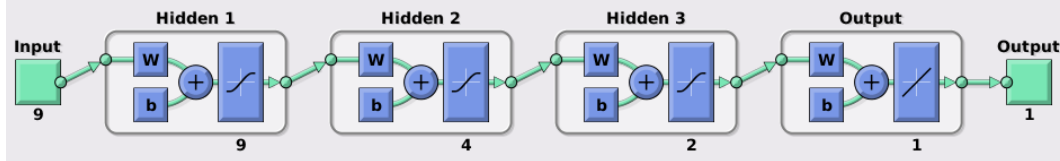
Figure 3. An exemplary structure of the neural network with 9 inputs used in experiments.